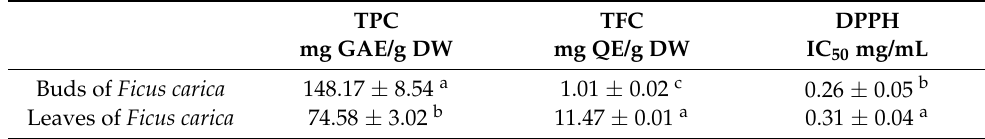
Table 1. Phytochemical content and antioxidant activity of different extracts of leaves and buds of Ficus carica . TPC TFC DPPH mg GAE/g DW mg QE/g DW IC 50 mg/mL Buds of Ficus carica 148.17 ± 8.54 a 1.01 ± 0.02 c 0.26 ± 0.05 b Leaves of Ficus carica 74.58 ± 3.02 b 11.47 ± 0.01 a 0.31 ± 0.04 a Values in the same column followed by different letters are significantly